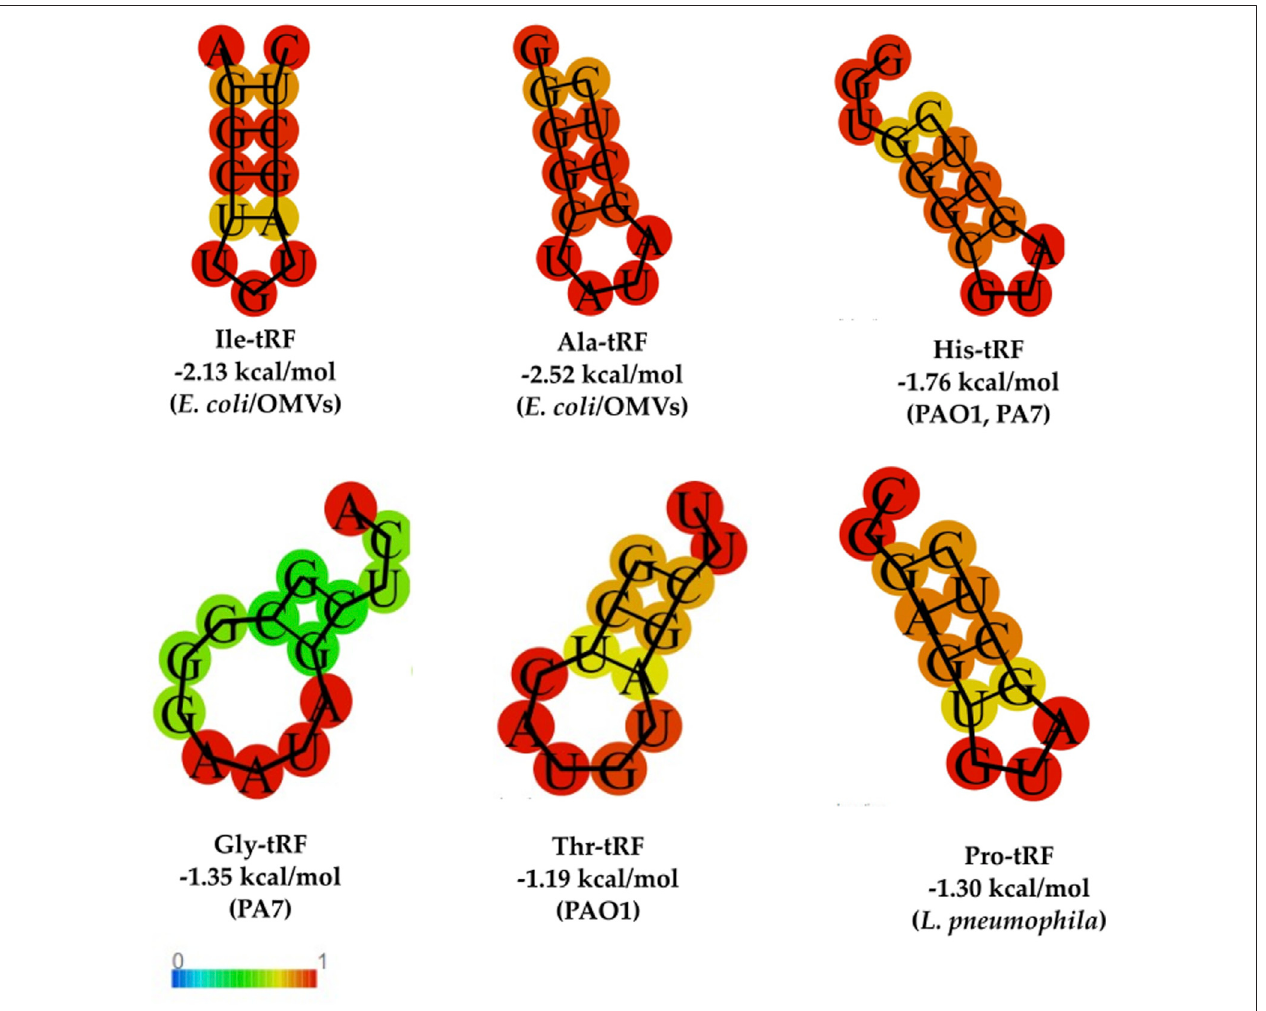
FIGURE6| IllustrationofthesecondarystructureofthesixmostabundanttRFs.RNAfoldwasusedforRNAsecondarystructureprediction.Thevaluesinkcal/mol represent the minimum free energies. The probability of the base pairs is color-coded 0 to 1, with the red color corresponding to higher con fi dence. All oligonucleotides analyzed have at least 2 G-C base pairs that provide for stem loop